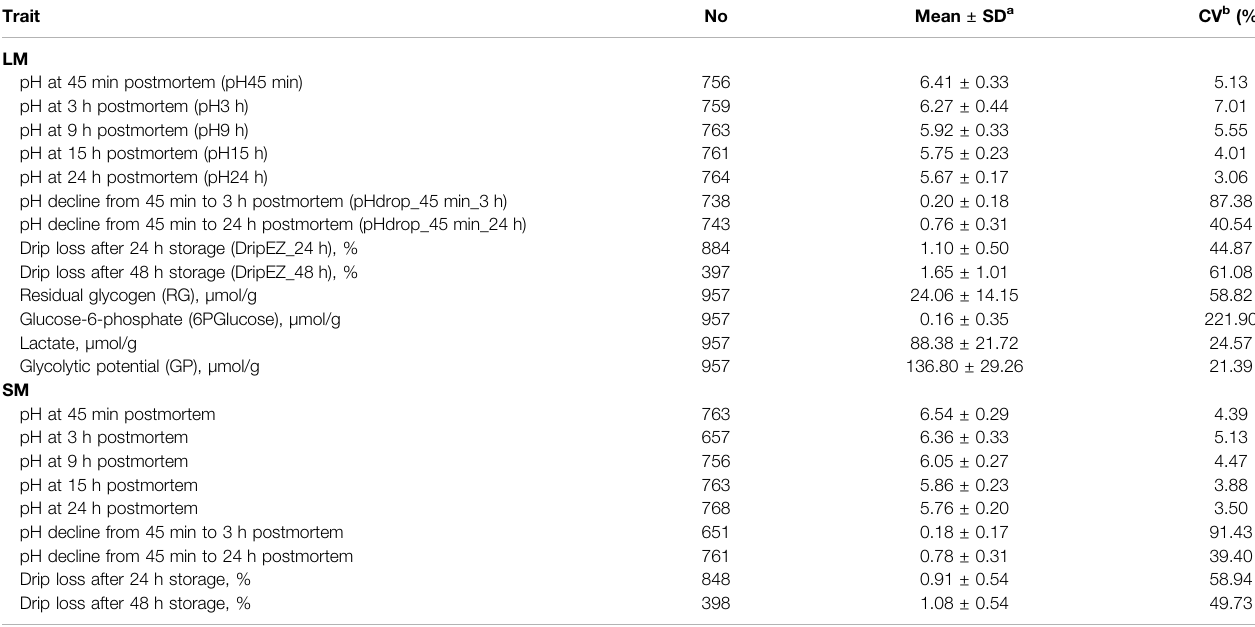
TABLE 1 | Descriptive statistics of 22 meat quality traits measured on longissimus dorsi muscle (LM) and semimembranosus muscle (SM).